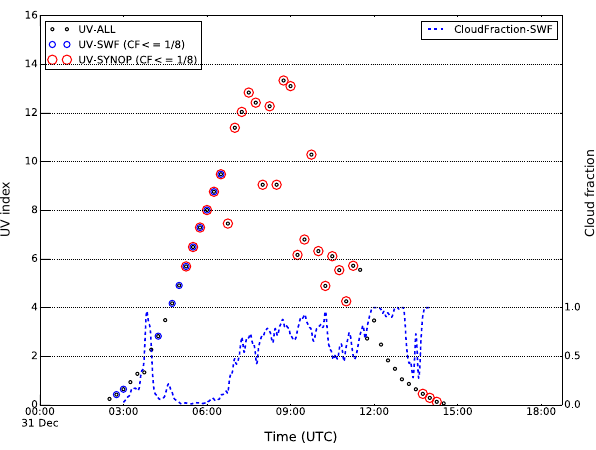
Figure 1. Daily UV index at Reunion Island on 31 December 2010; for UV-ALL Bentham measurements in black circles, UV-SWF: UV data filtered with CF-SWF in blue circles, UV-SYNOP: UV data filtered with CF-SYNOP in red circles. Cloud fraction (CF- SWF) is also represented by the blue dashed